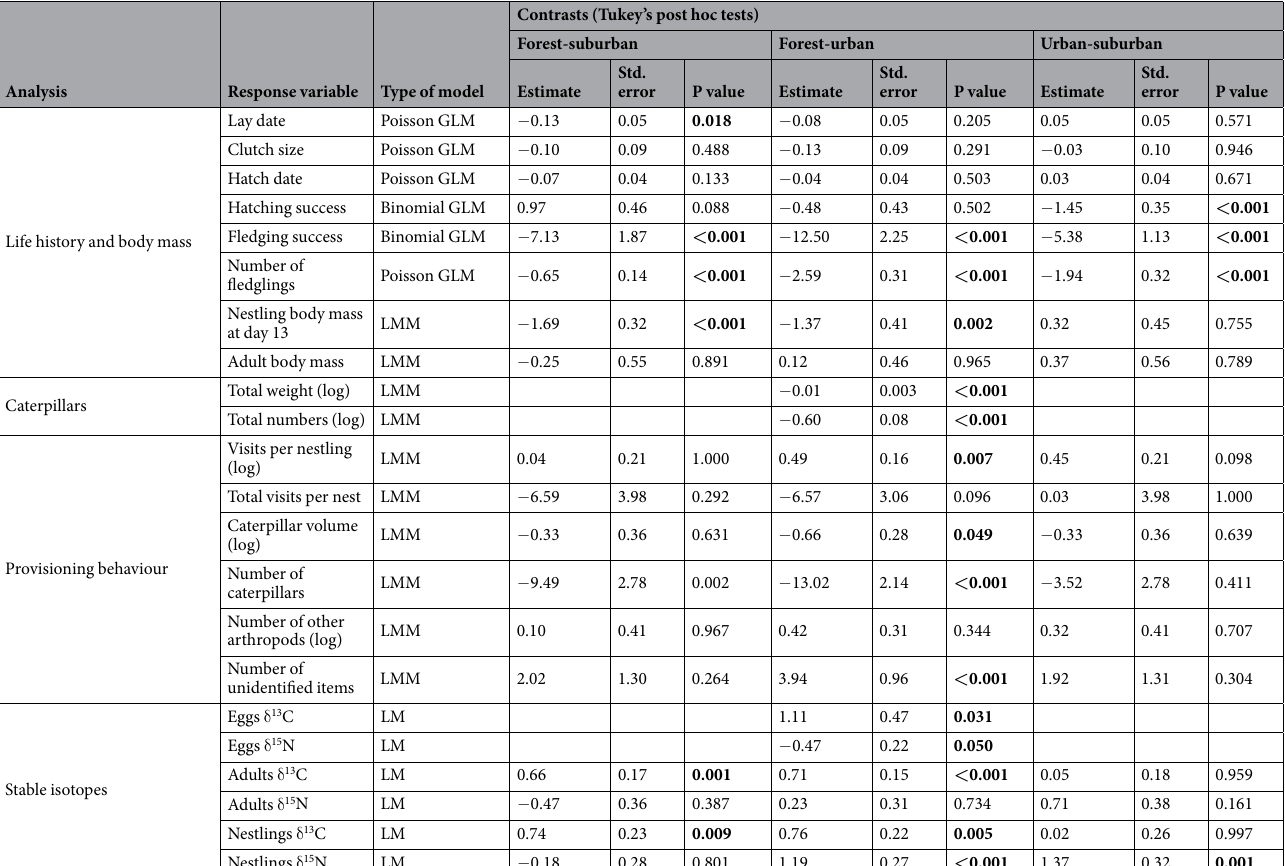
Table 1. Summary of Tukey’s posthoc tests for all linear contrasts of all models. For full model results see Tables 3, 4, 5 and 6. Bold characters highlight significant